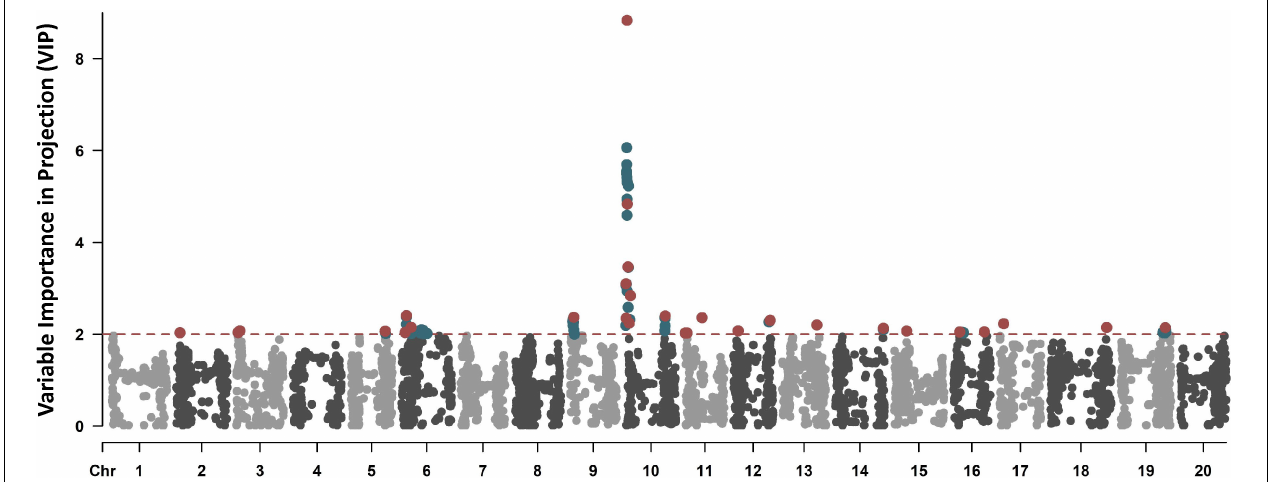
FIGURE 1 | Variable Importance in Projection (VIP)-based Manhattan plot of the 4,974 SNPs. The SNPs with VIP scores higher than 2.0 are highlighted in blue, and the 29 non-correlated SNPs with VIP scores higher than 2.0 selected to be used in the ML-based GWAS are colored in red.